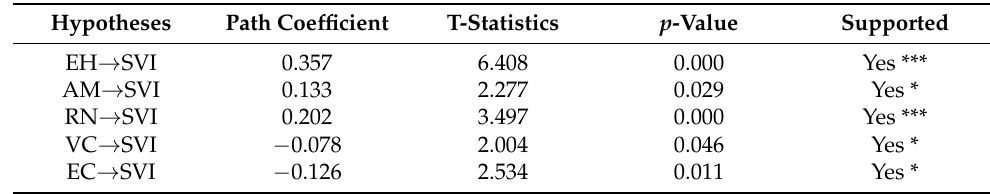
Table 4. Results of Hypotheses Testing.